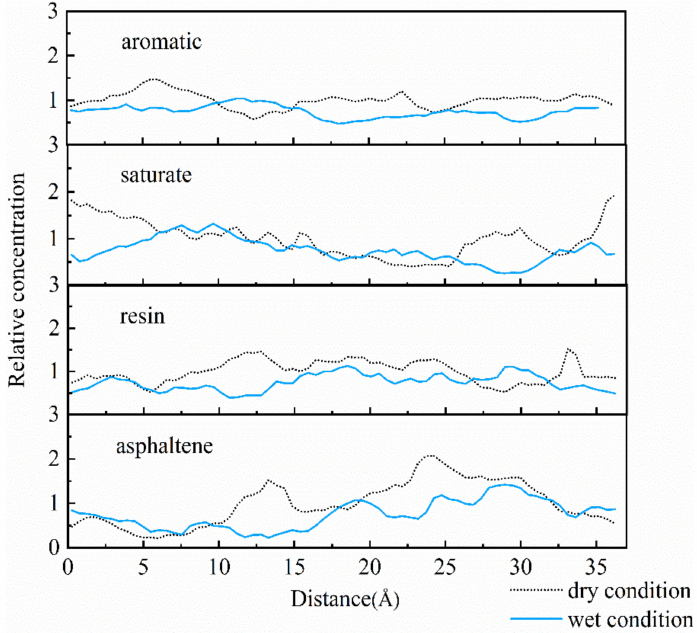
Figure 4. Relative concentrations of the asphalt-albite interface